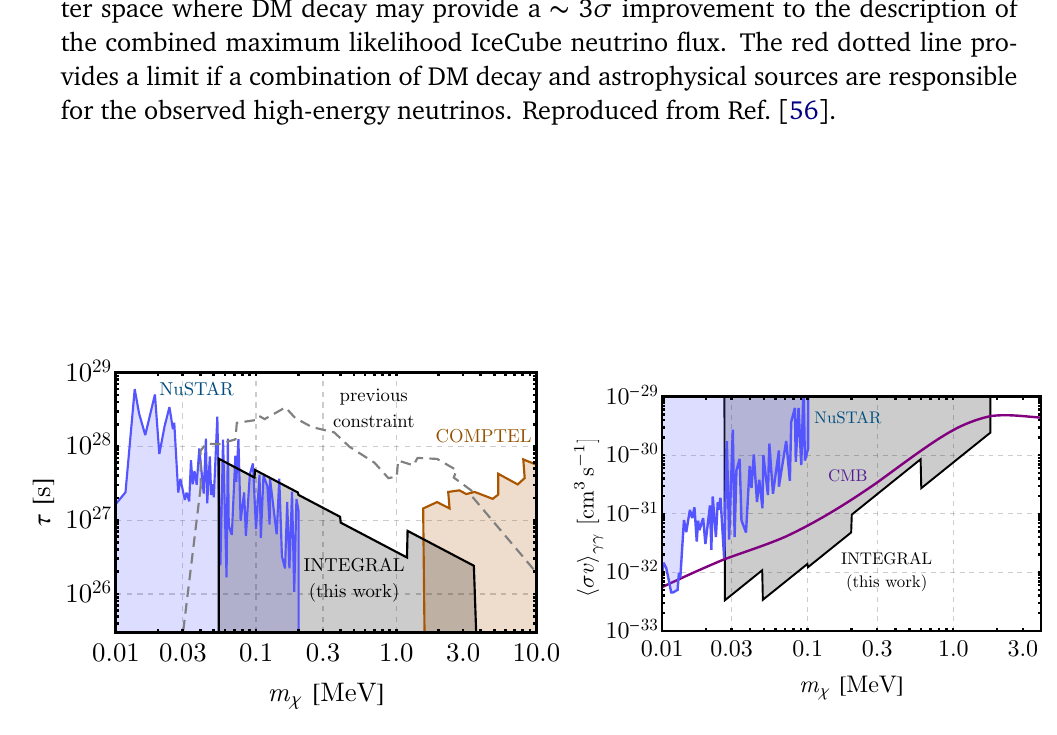
Figure 12: Selected bounds on the DM decay lifetime ( left panel ) and annihilation cross section ( right panel ) for annihilation / decay to γγ , using data from the NuSTAR X-ray telescope, the CMB, and the INTEGRAL and COMPTEL gamma-ray telescopes. Reproduced from Ref. [ 119 ] ; see that work for further details. A compilation of bounds at lower / higher masses can be found in Ref. [ 120 ]